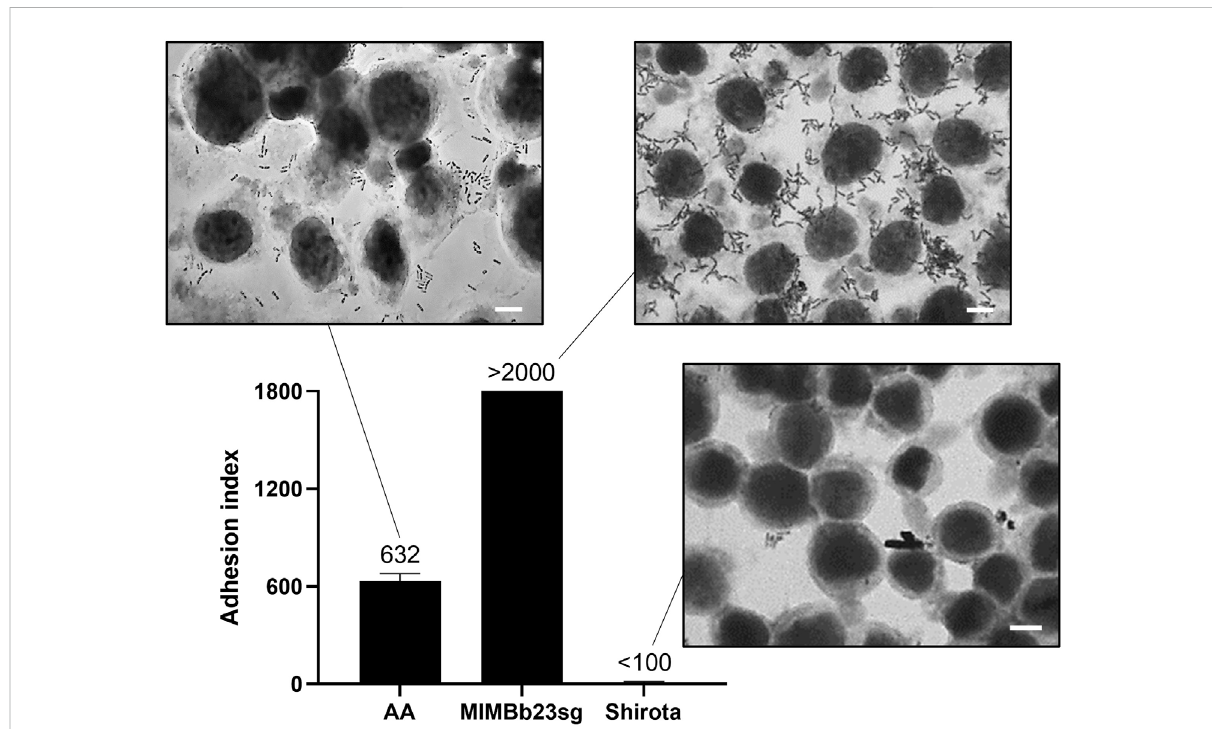
FIGURE 1 AdhesionofthebacterialcellswithintheAminoAlta ™ probioticformulationtoaCaco-2cellmonolayerasobservedwithGiemsastainingunder a light microscope. Adhesion quanti fi cation is reported as adhesion index (i.e., bacterial cells adhered to 100 Caco-2 cells). Histograms represent means of at least three independent experiments conducted in duplicate. The vertical bars indicate standard deviations. AA, AminoAlta ™ formulation; MIMBb23sg, Bi fi dobacterium bi fi dum MIMBb23sg (positive control); Shirota, Lacticaseibacillus paracasei Shirota (negative control). White bar, 10 μ